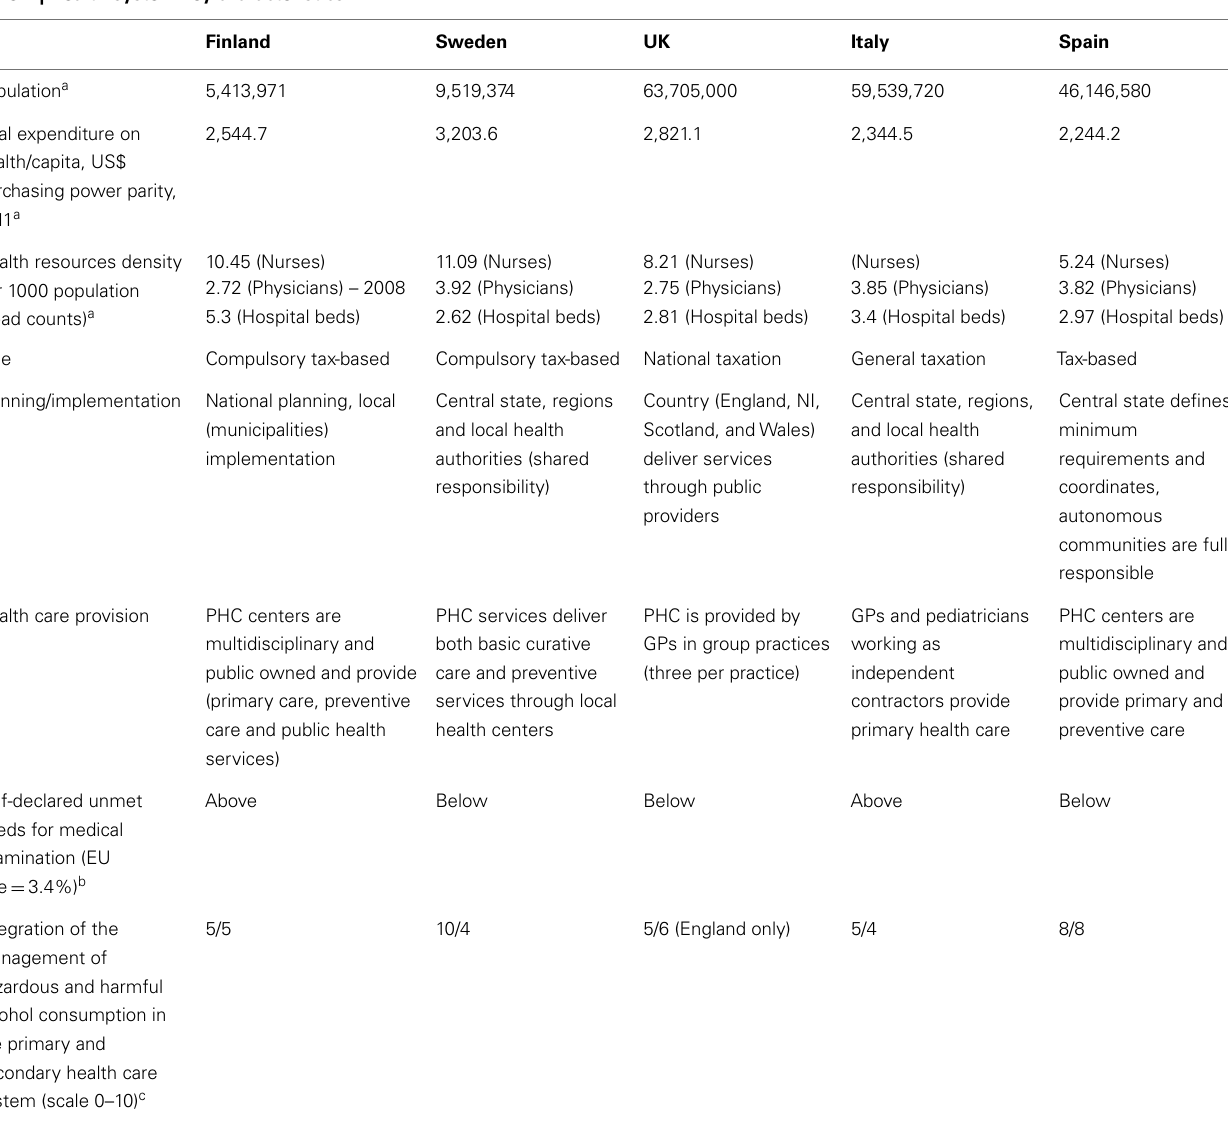
Table 1 | Health system key characteristics